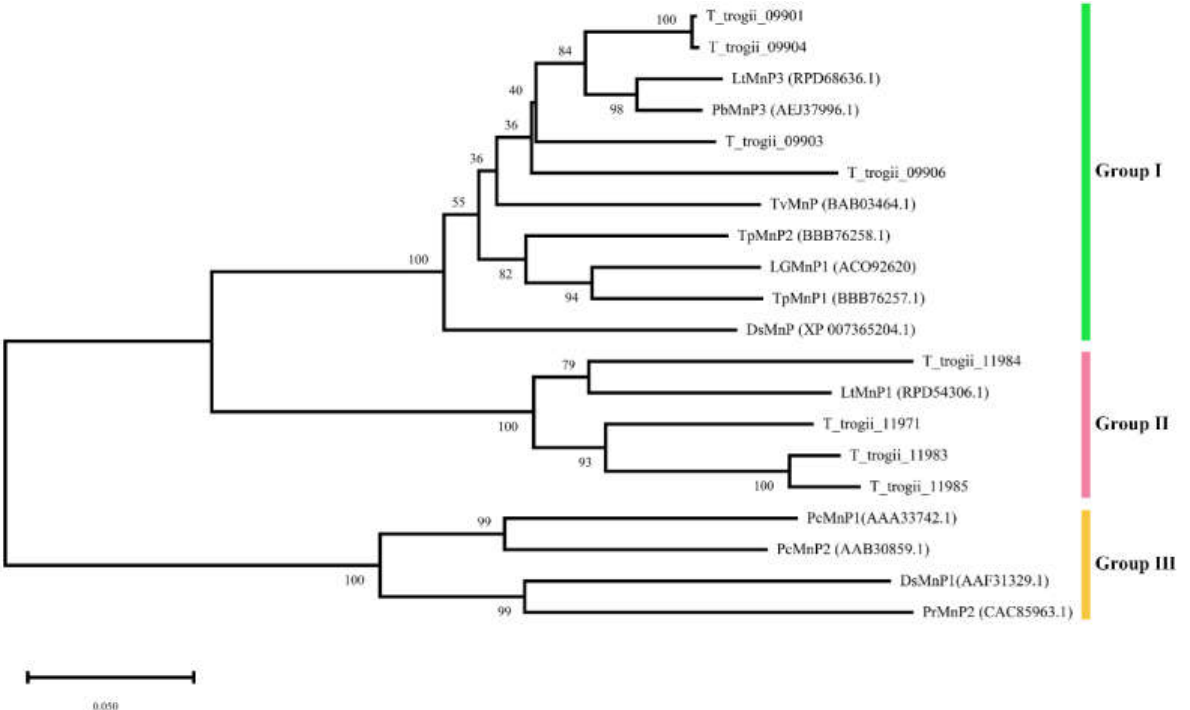
Figure 1. Maximum likelihood phylogenetic tree from TtMnPs and many related MnPs.